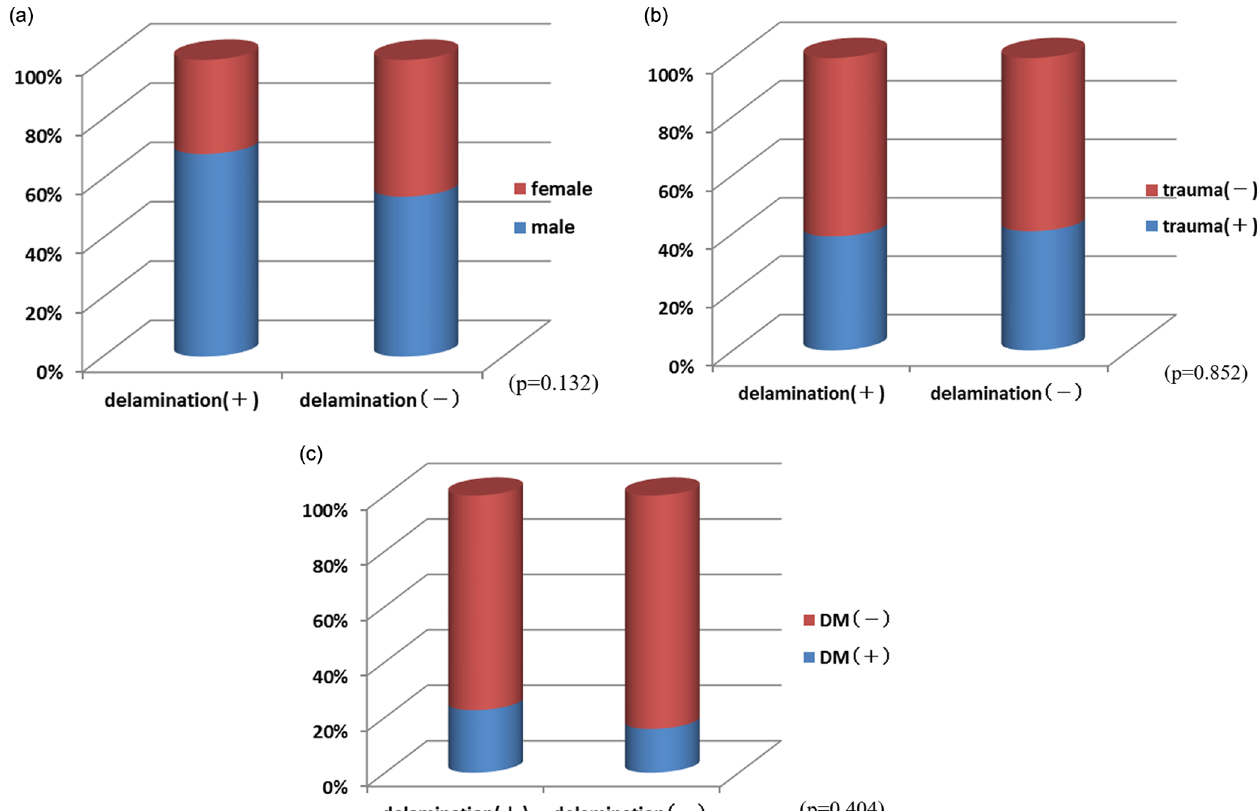
Figure 1. (a) Relation between delamination and gender. (b) Relation between delamination and history of trauma. (c) Relation between delamination and diabetes.